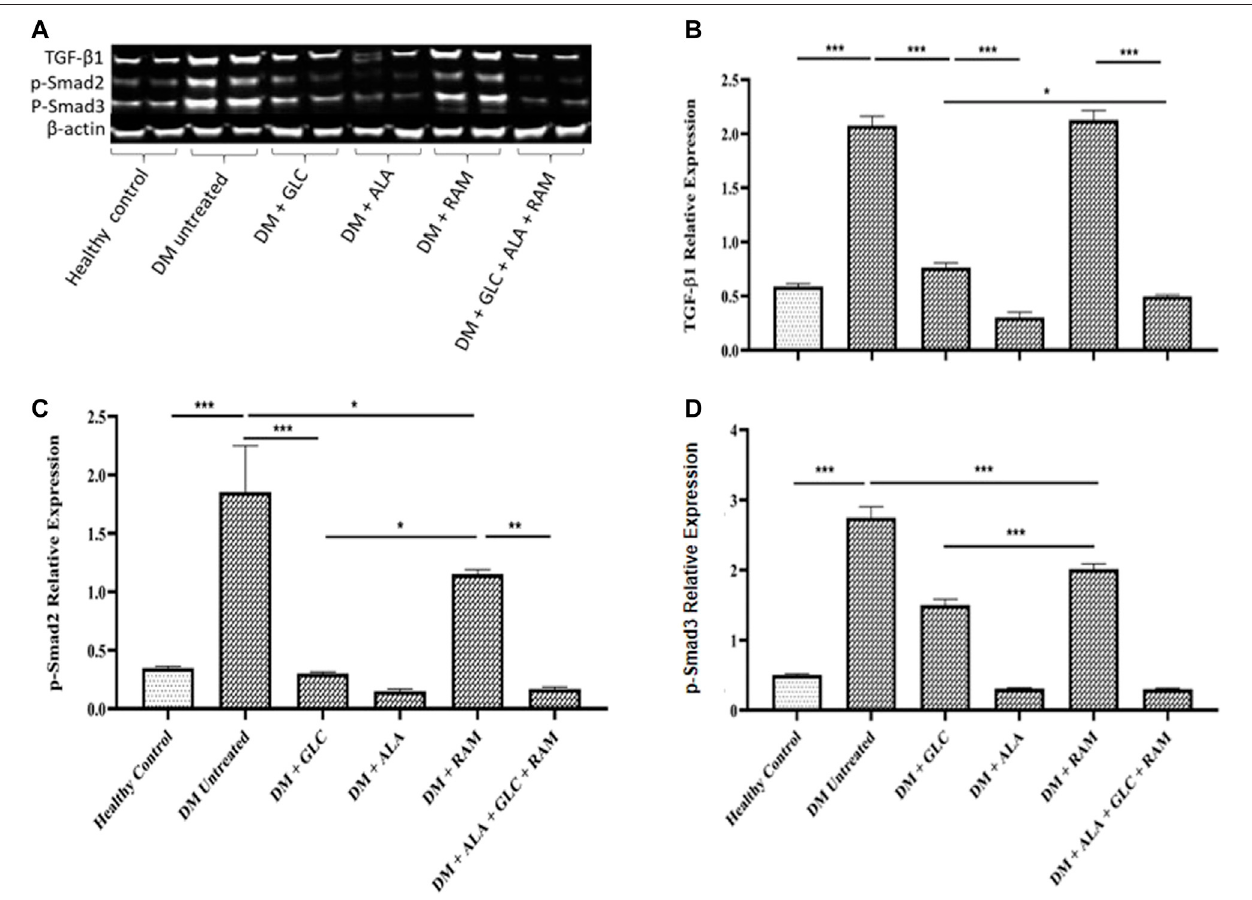
FIGURE5| Cardiac fi brosisshowing (A) Westernblotimage,andquanti fi cationof (B) transforminggrowthfactor-beta1(TGF- β 1), (C) phosphorylatedSmad2and (D) phosphorylatedSmad3.Healthycontrol( n =7);DMUntreated=Untreateddiabetesmellitusrats( n =9);DM+GLC=Diabeticratstreatedwithgliclazide( n =7);DM+ ALA = Diabetic rats treated with alpha-lipoic acid ( n = 7); DM + RAM = Diabetic rats treated with ramipril ( n = 7); DM + ALA + GLC + RAM = Diabetic rats treated with alpha-lipoic acid, gliclazide and ramipril ( n = 7). * p < 0.05 vs. diabetic control, ** p < 0.01 vs. diabetic control, *** p < 0.001 vs. diabetic control.